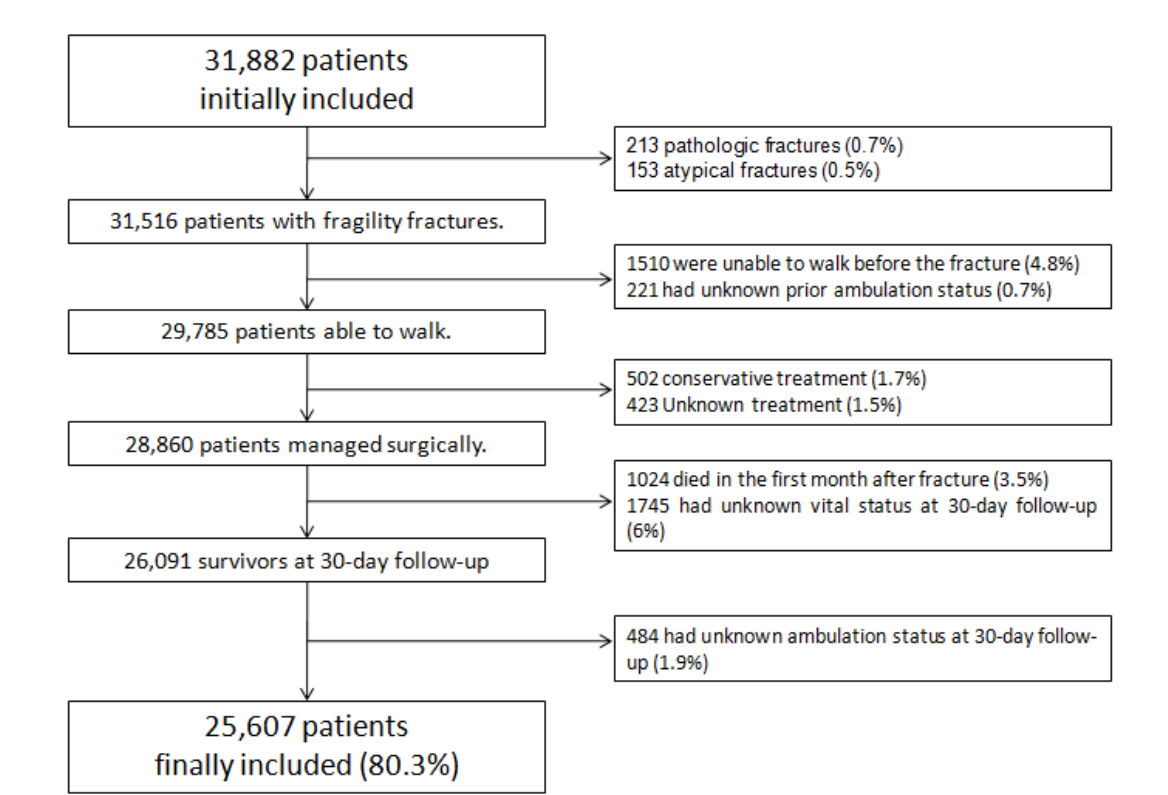
Figure 1. Inclusion and exclusion criteria.